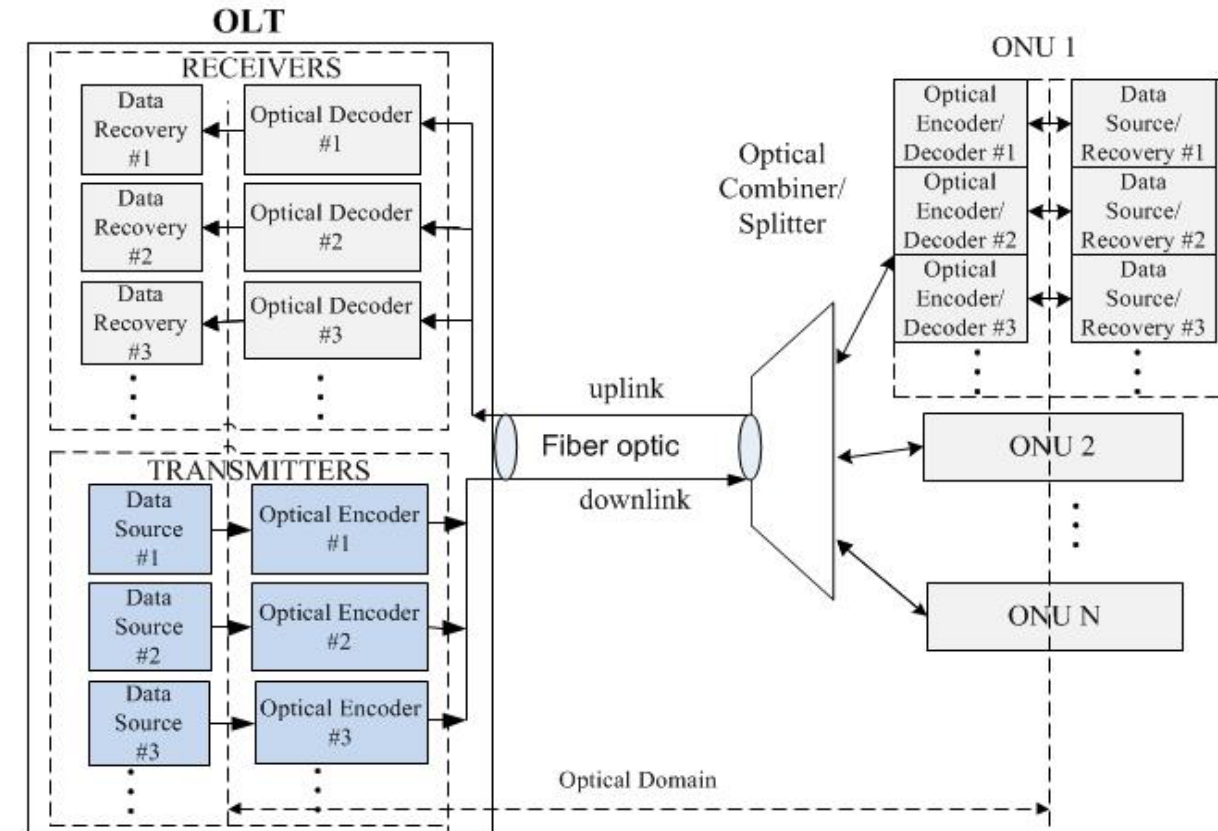
Figure 15. OCDMA-PON architecture.